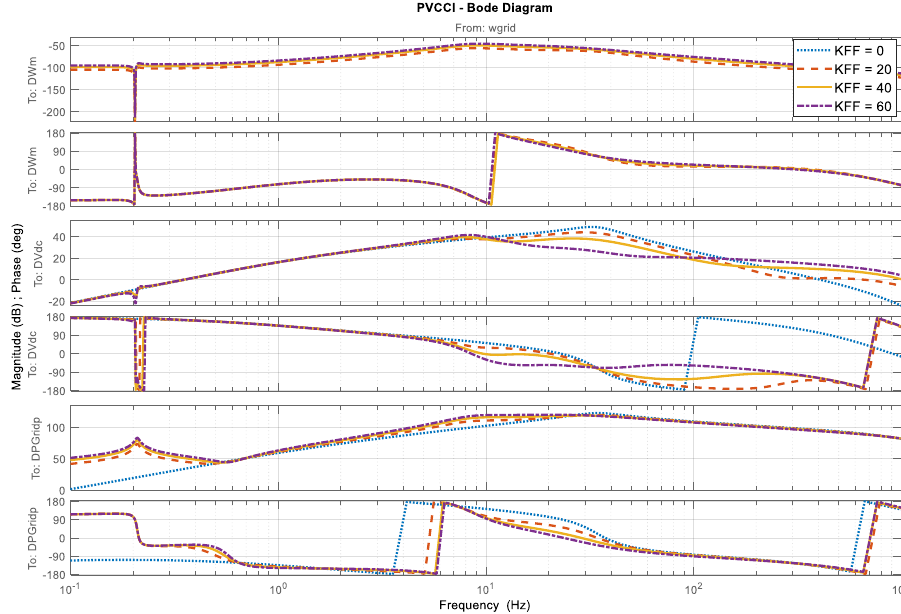
Figure 23. PVCCI Bode plots showing the effect of inertia feedforward to the generator.